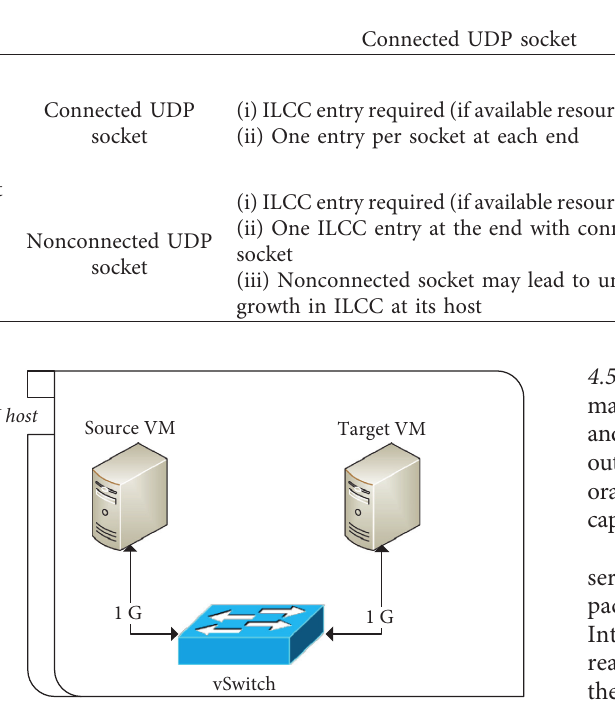
Figure 1: Experiment network and